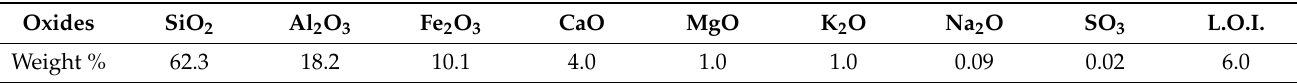
Figure 2. SEM images of the Montmorillonite (MMT) sample at different magnifications: ( i ) 4000 × and ( ii ) 50,000 × . Table 1. Chemical constituents of Montmorillonite as inferred by EDX *.